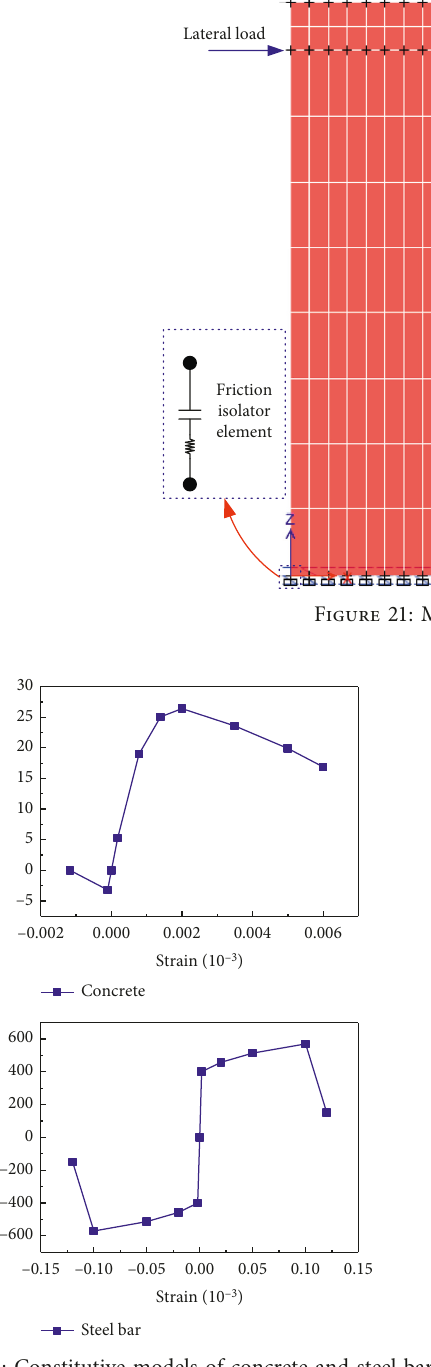
23: Distribution of concrete stress of SW2